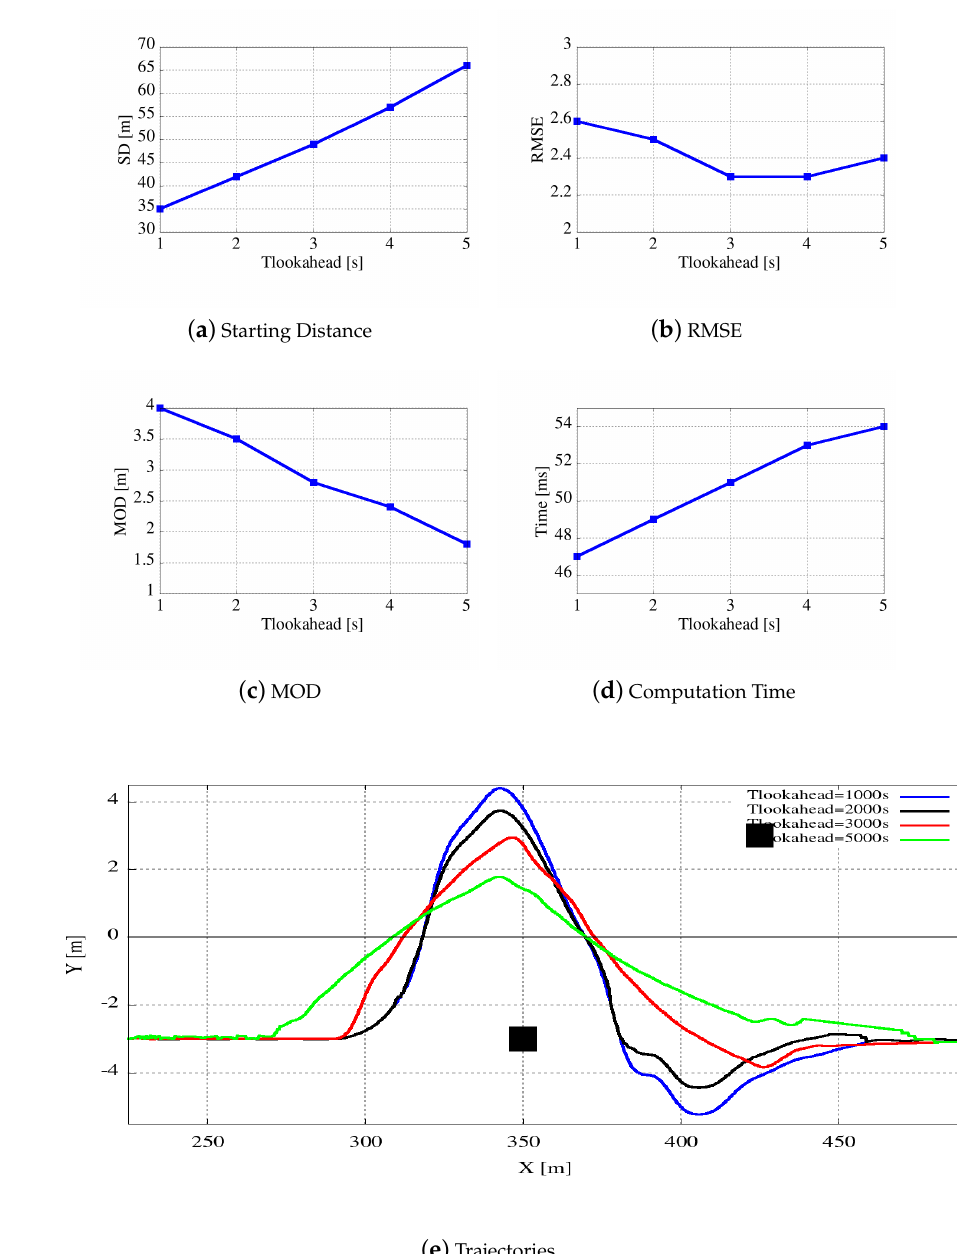
Figure 12. Parameters and paths evaluation for an overtaking maneuver as a function of the height of the tree T lookahead parameter varying from 1 to 5 s. Graphs plot the starting distance ( a ), the root mean square error ( b ), the minimum obstacle distance ( c ), and the computation time ( d ). ( e ) shows the reference path and the final trajectories obtained with the different parameters. The car speed is fixed at 25 m/s (90